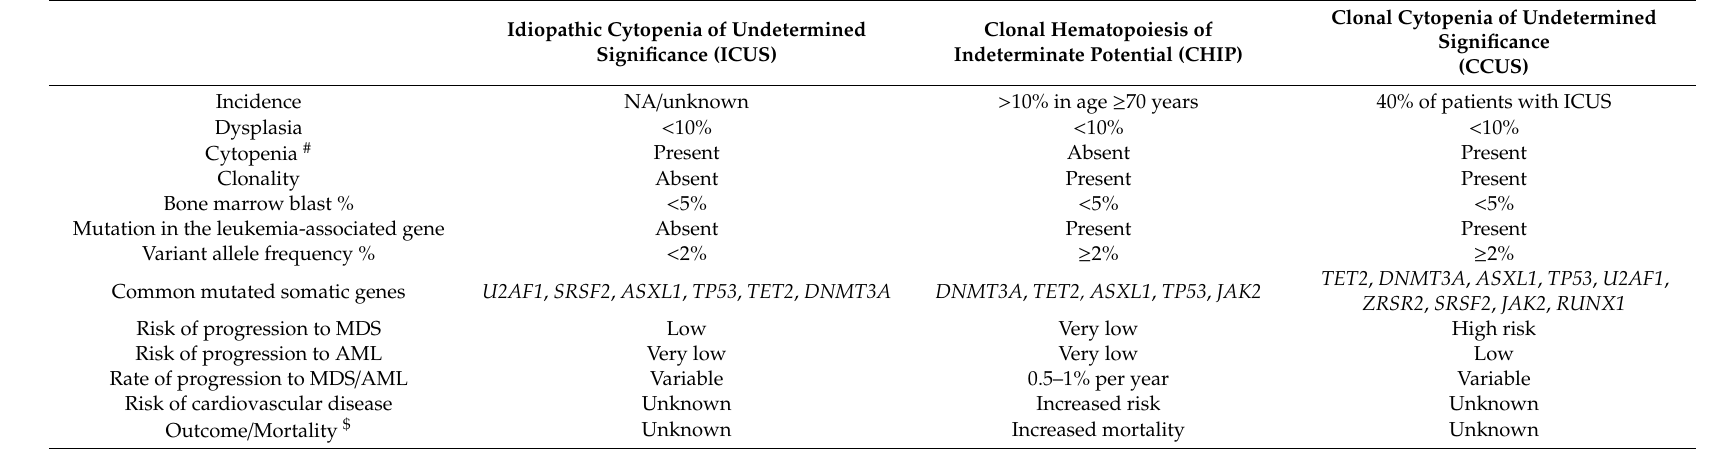
Table 1. Clinical and molecular characteristics of ICUS, CHIP, and